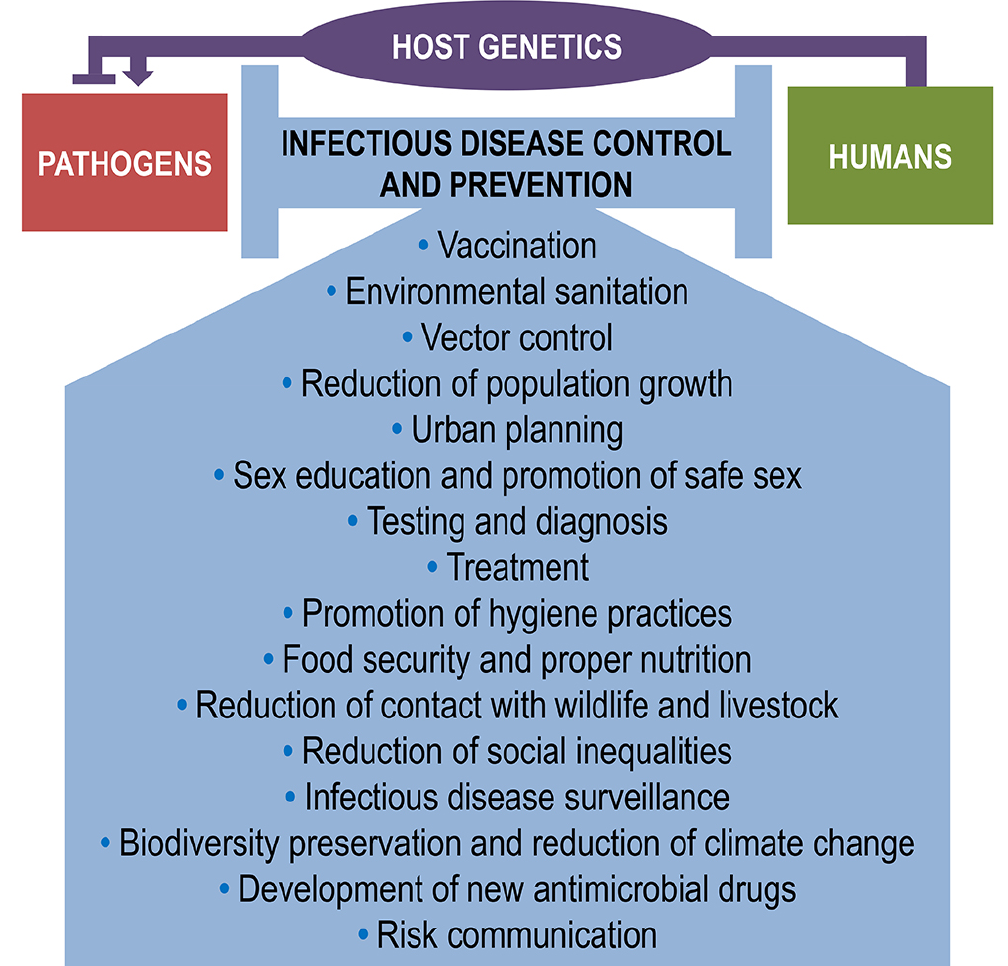
Figure 2 – Actions for infectious disease control and prevention. The interactions between humans and pathogens can be facilitated or avoided depending on the presence or absence of actions of control and prevention of infectious diseases. Moreover, host genetics affects host-pathogen interactions: for example, HLA alleles and genetic polymorphisms can increase or decrease susceptibility to infectious diseases. These genetic traits also affect the progression of infectious diseases. This figure is based on references and discussions mentioned throughout the